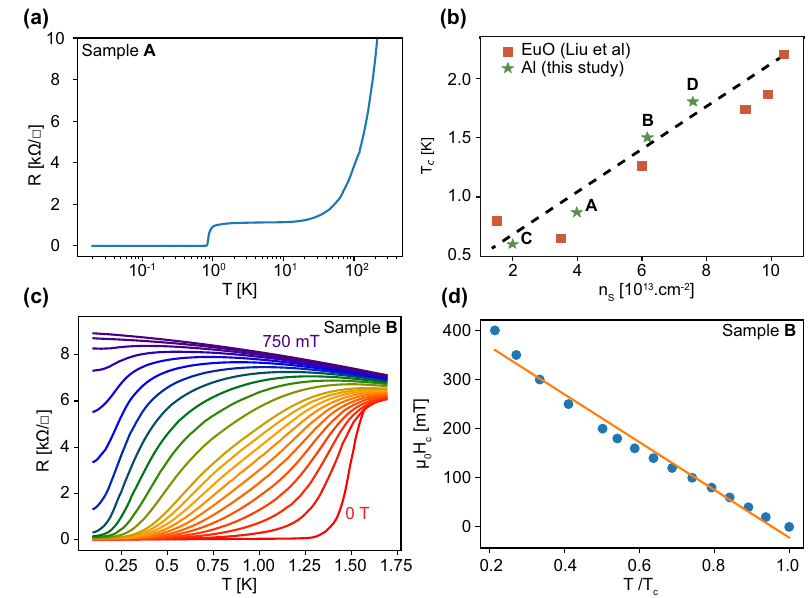
Fig. 2 | Magneto-transport characterization. a Sheet resistance of sample A as a function of temperature (log scale) showing a superconducting transition at T c ≃ 0.9 K. b Summary of the superconducting critical temperature as a function of the carrierdensity for all samplesstudied in thisworkcompared with results from